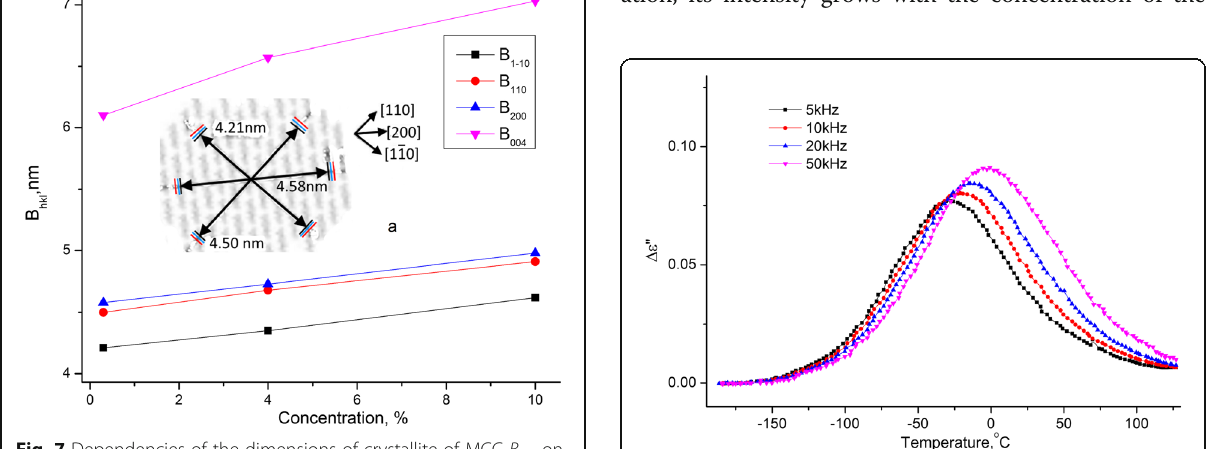
Fig. 9 Temperature dependence of imaginary part of the dielectric permittivity of MCC + 0.3% H 2 O on frequencies 5, 10, 20, and 50